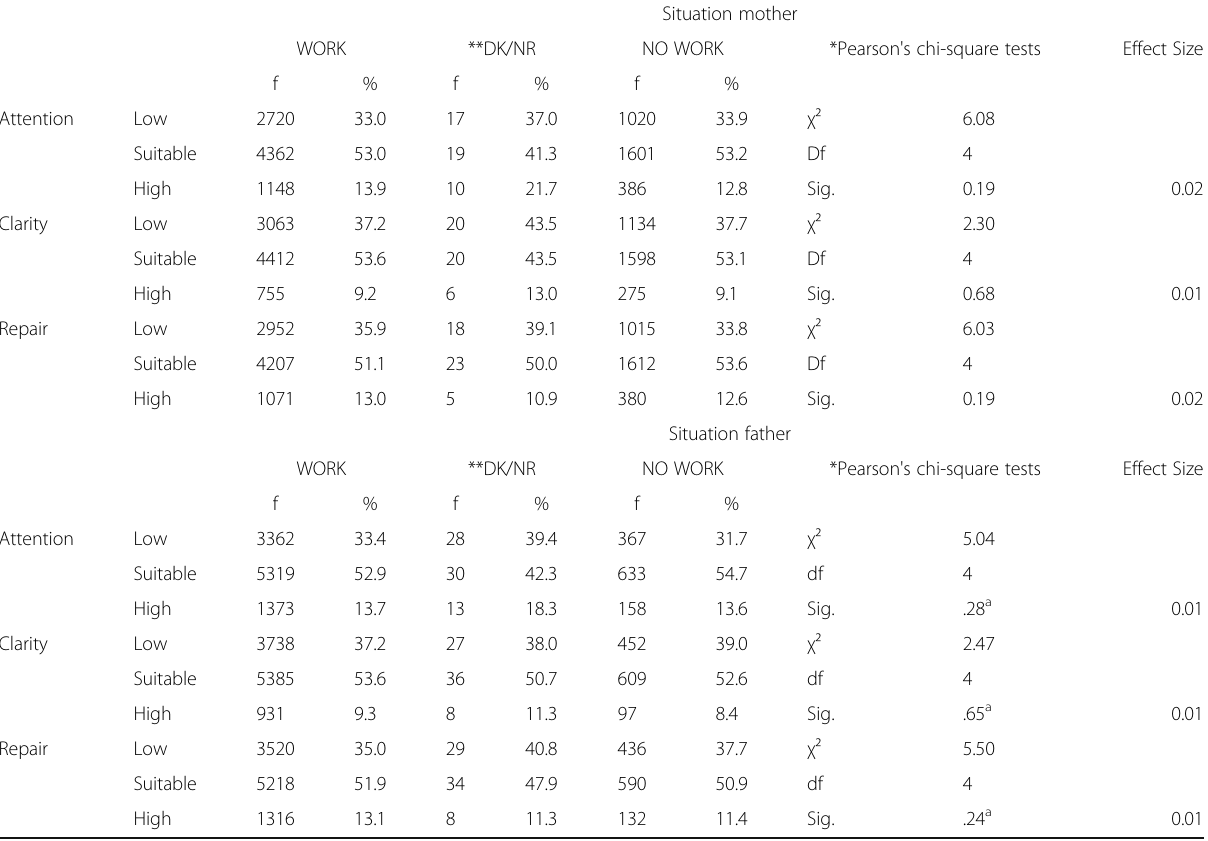
Table 5 Self-perception of emotional intelligence according to the employment situation of mothers and fathers. Test chi-squared and Effect sizes for Cramer ’ s V